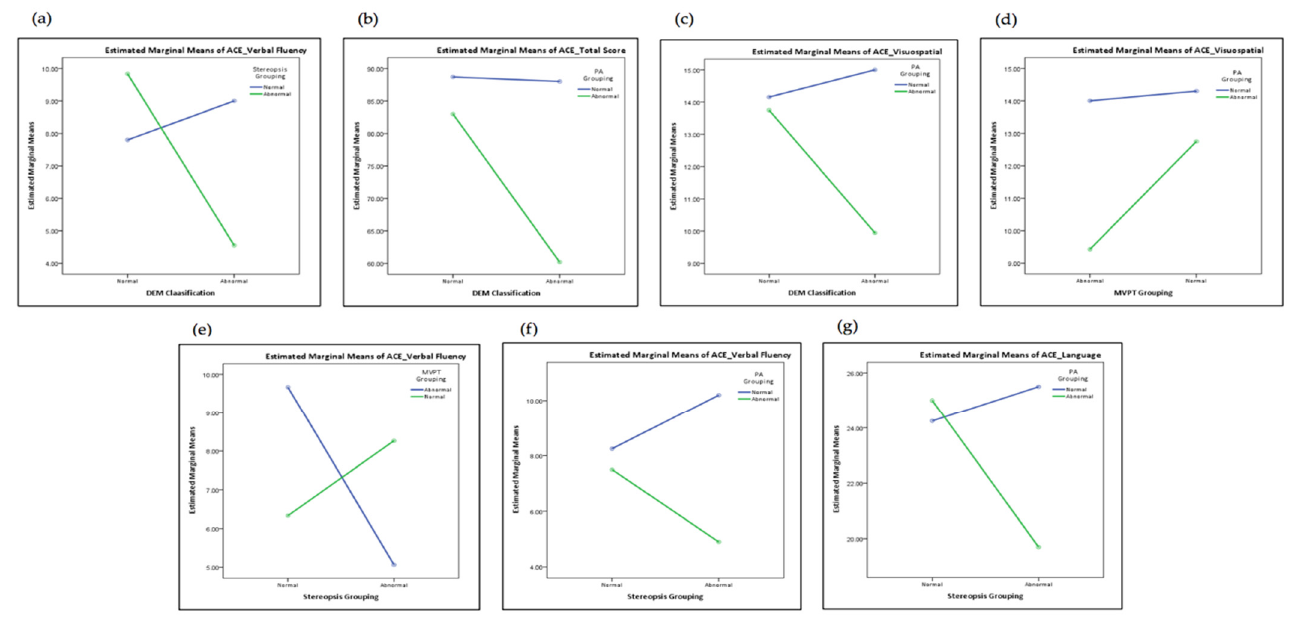
Figure 4. Interaction between visual function, visual perception, and cognitive function: ( a ) ACE visual fluency, DEM and stereopsis; ( b ) ACE total score, DEM, and peripheral awareness (PA); ( c ) ACE visuospatial, DEM, and peripheral awareness (PA); ( d ) ACE visuospatial, MVPT-4, and peripheral awareness (PA); ( e ) ACE visual fluency, stereopsis, and MVPT-4; ( f ) ACE visual fluency, stereopsis, and peripheral awareness; ( g ) ACE language, stereopsis, and peripheral